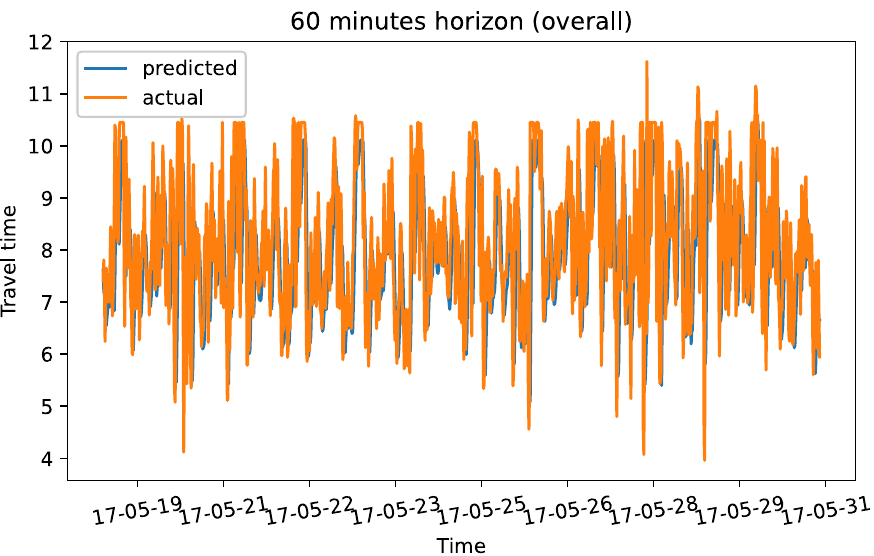
Fig 12. Prediction results for 60 minutes horizon on test data